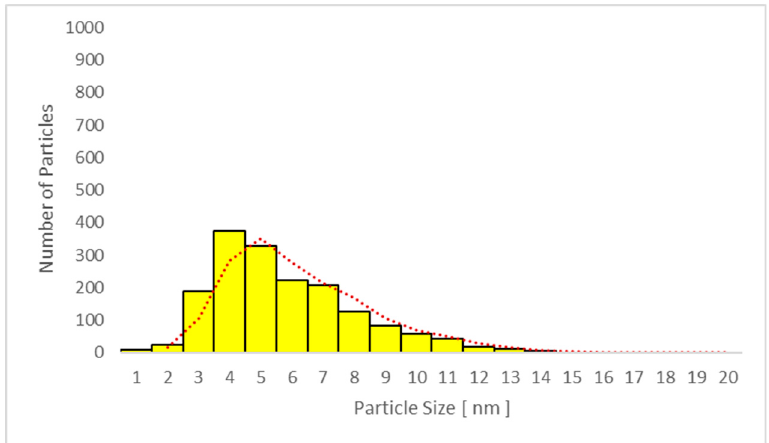
Figure 11. Particle size distribution detected using transmission electron microscopy (TEM) in plasma sample 4 in study C (sunscreen + UV) (one week after sunscreen removal). The average particle size was 7.8 nm in all subjects.